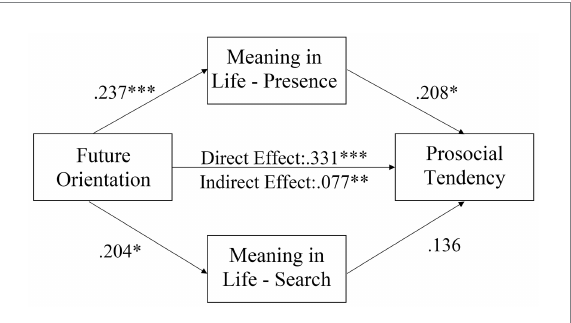
FIGURE 3 A hypothetical model for the relationships among major variables (male sample). * p < 0.05; ** p < 0.01, *** p < 0.001.